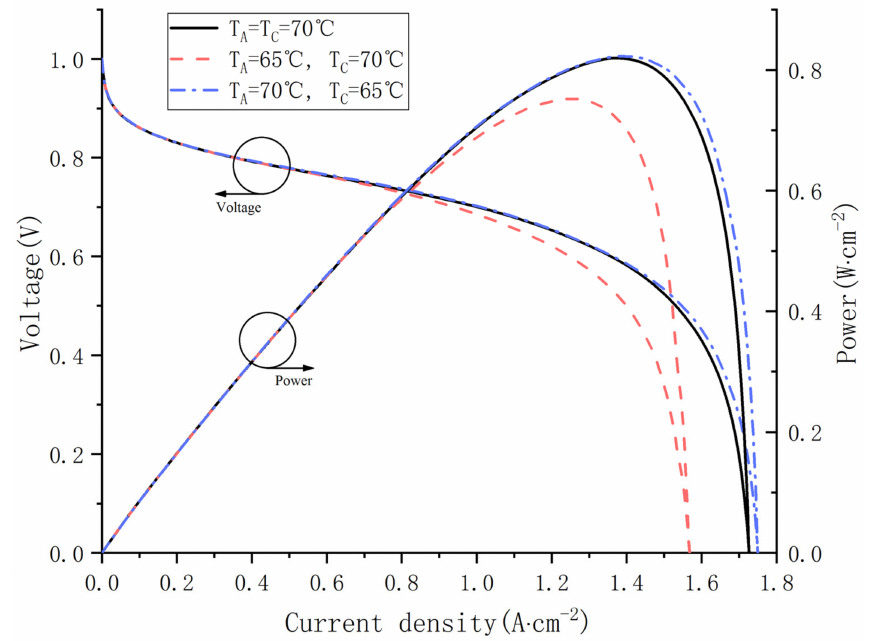
Figure 12. Polarization curves and power curves at different gas inlet temperature.